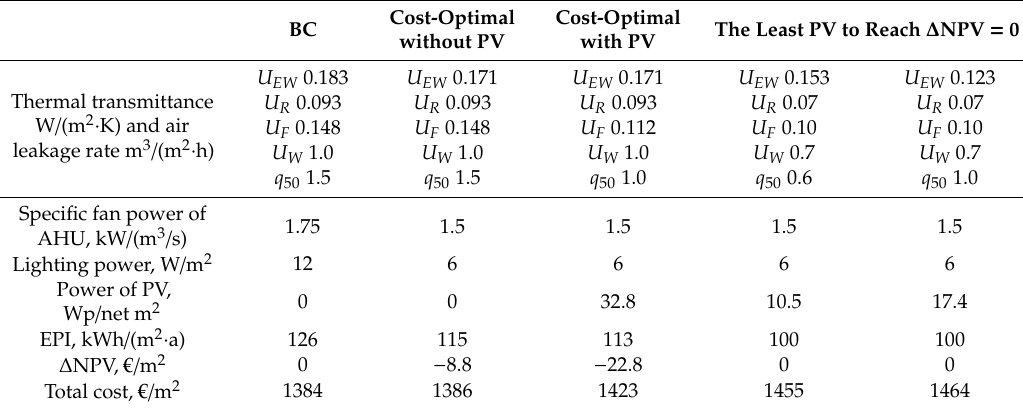
Table 7. Most e ffi cient solutions compared to the reference building.